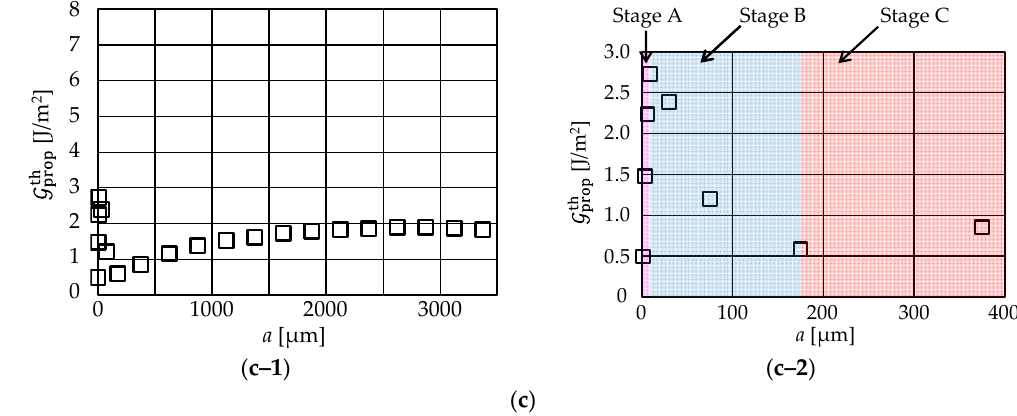
Figure 7. Relationships between ERR for interface crack propagation due to the thermal stress and crack length at objective interfaces in T/EBC with h SA = 5 µm and h Mu = 20 µm; ( a ) SiC/SiAlON interface: